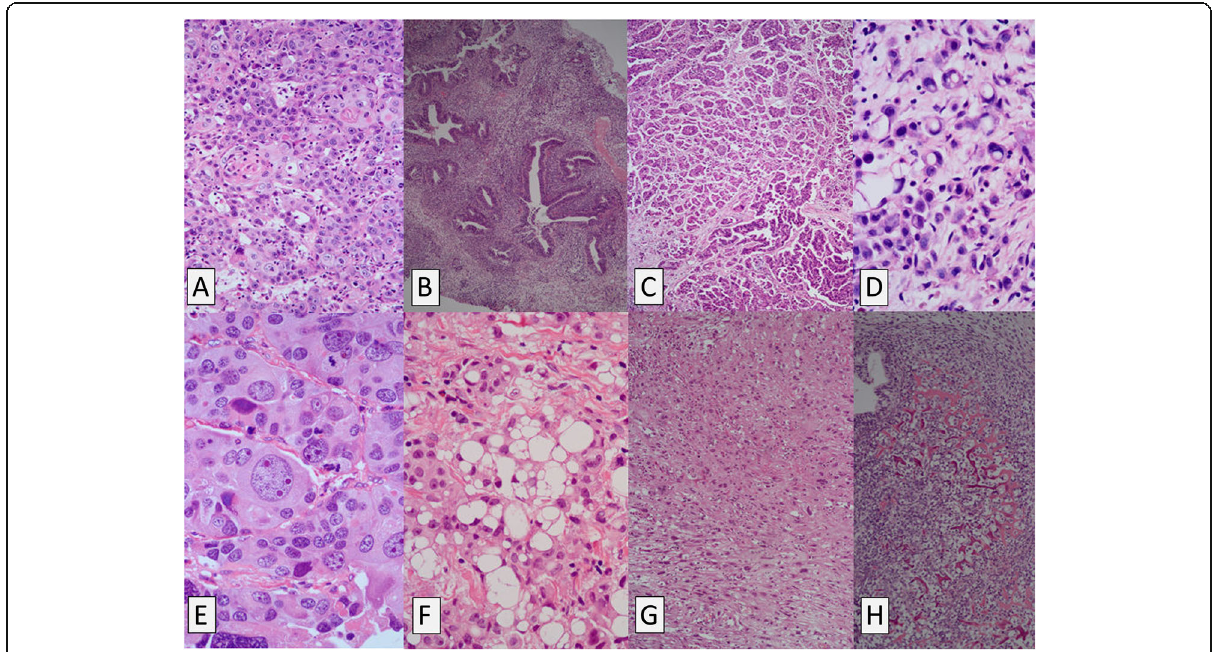
Fig. 1 Divergent differentiation in urothelial carcinoma of cases from the present series. a Squamous (HE, 100x); b Glandular (HE; 40x); c Micropapillary (HE; 40x); d Plasmacytoid (HE, 400x); e Poorly differentiated (HE, 400x); f Lipid-rich (HE, 100x); g Sarcomatoid (HE, 40x) and h ) Sarcomatoid with heterologous osteosarcoma component (HE,